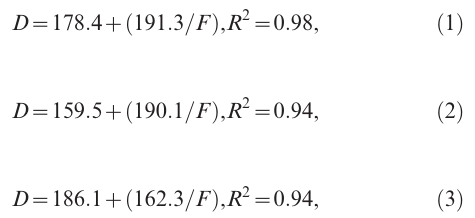
Table 2. The relationships between the diameter of the microfiber and the flow rate of the dispersed phase.